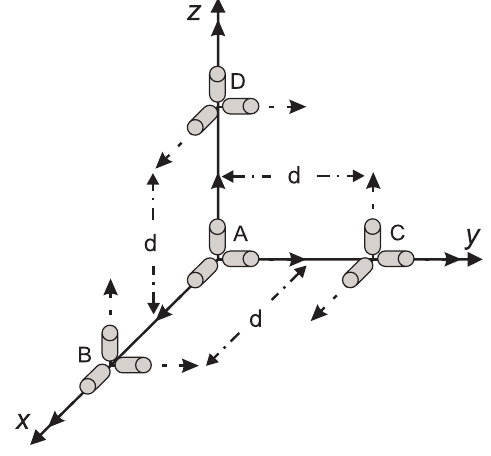
Figure 1. A configuration of multiple distributed tri-axial